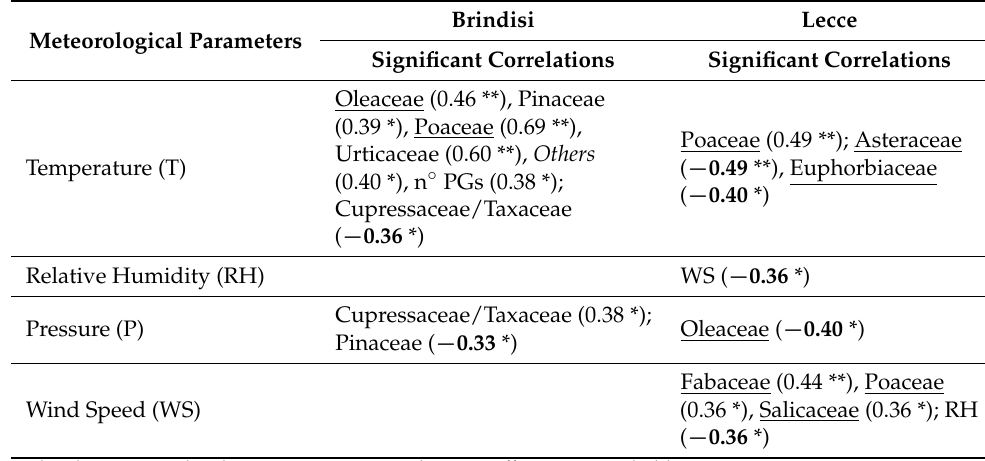
Table 2. Spearman correlation coefficients (reported in brackets) between meteorological parameters and pollen grain concentrations of the five families detected in more than 30% of samples, Others and Unclassified pollen grain concentrations, and the total pollen grain number (n ◦ PGs) concentrations of the samples collected in Brindisi. Spearman correlation coefficients (reported in brackets) be- tween meteorological parameters and the read concentrations for the nine families detected in Lecce and shared with Brindisi are also provided. The nine families shared between Lecce and Brindisi are